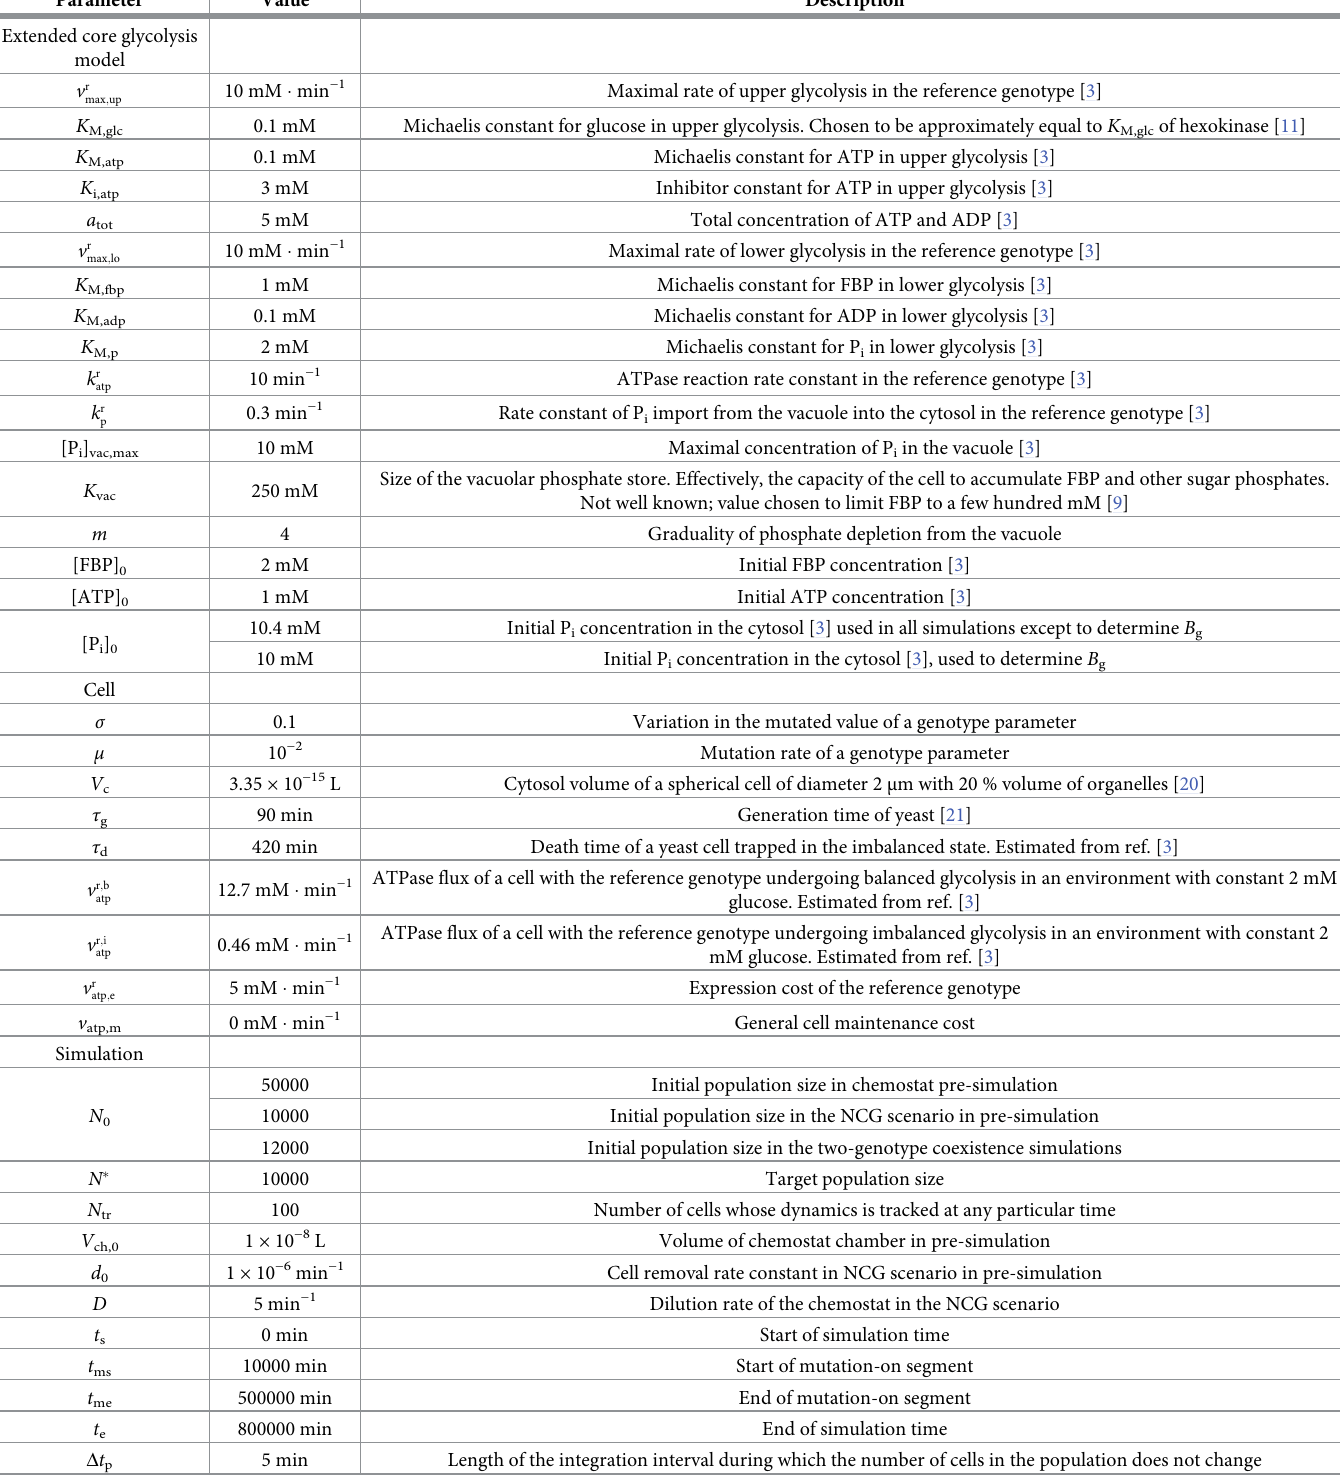
Table 1. Parameter values used in the